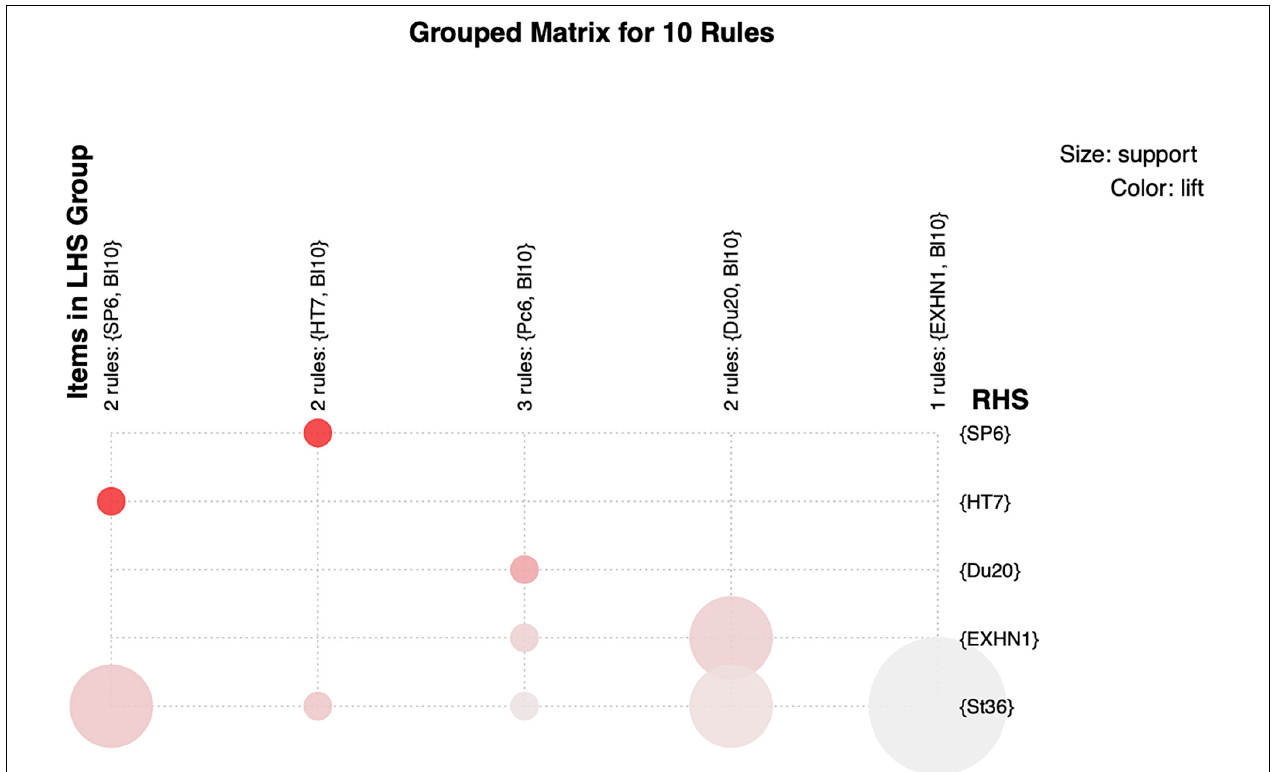
FIGURE 3 | Grouped matrix for 10 association